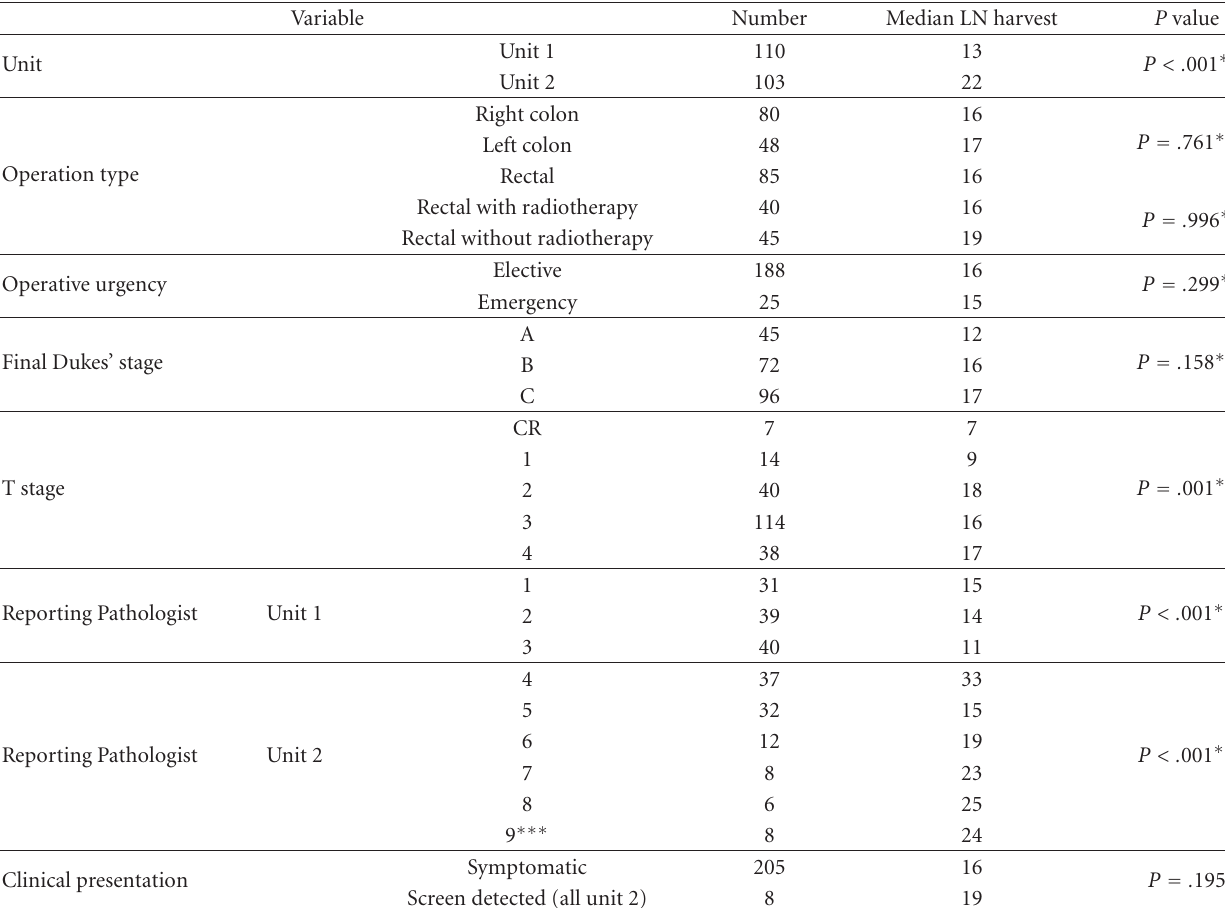
Table 3: Analysis of factors that may have influenced overall LN retrieval.